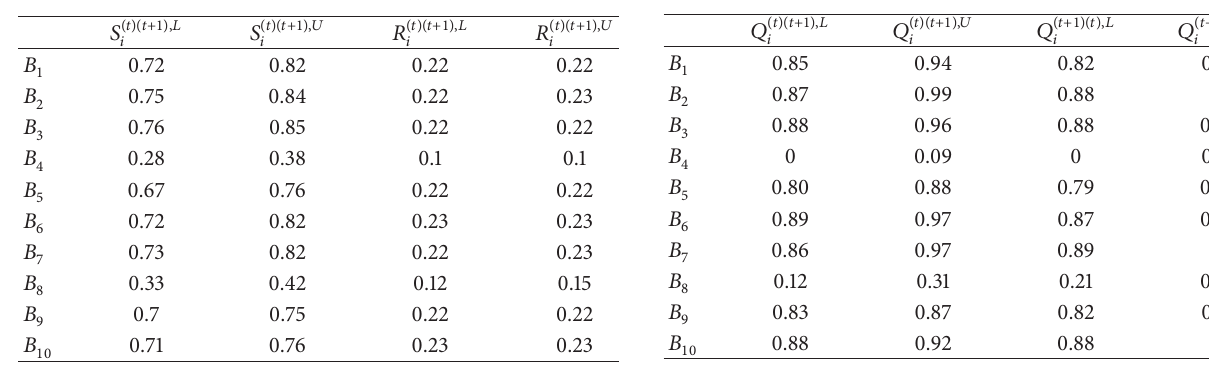
Table 14: 𝑆 and 𝑅 interval numbers (year of 2004-year of 2005).